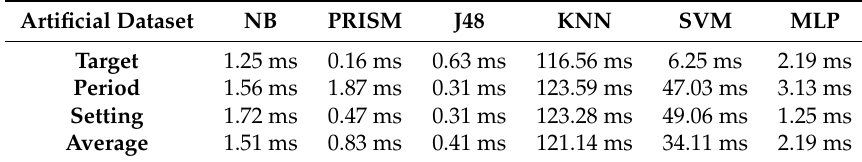
Table 8. CPU time test for classification.